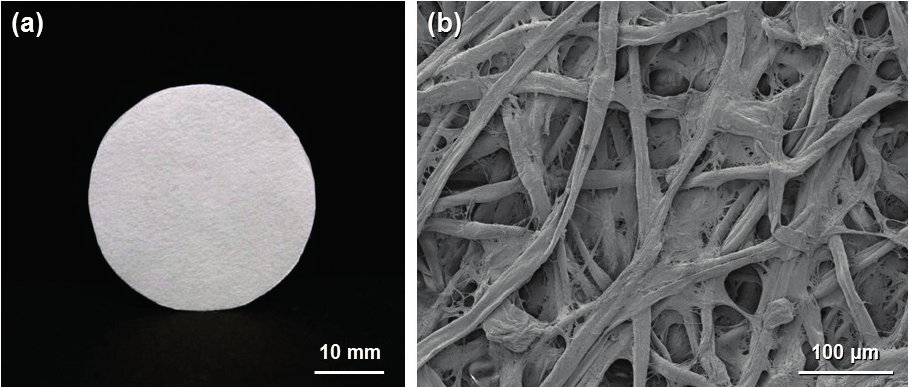
Figure 1. ( a ) Optical image of circular cellulose paper; and ( b ) field-emission scanning electron microscopy image of